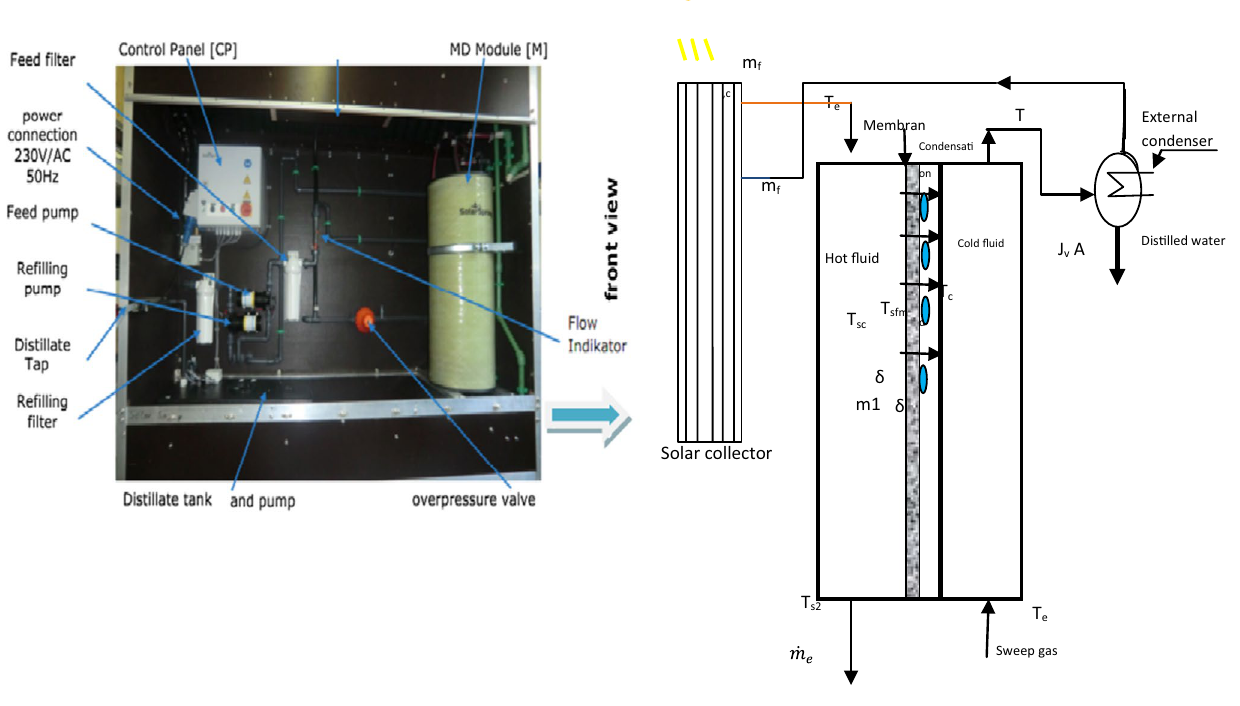
Fig. 5 Membrane distillation unit (SGMD) couples with solar collector